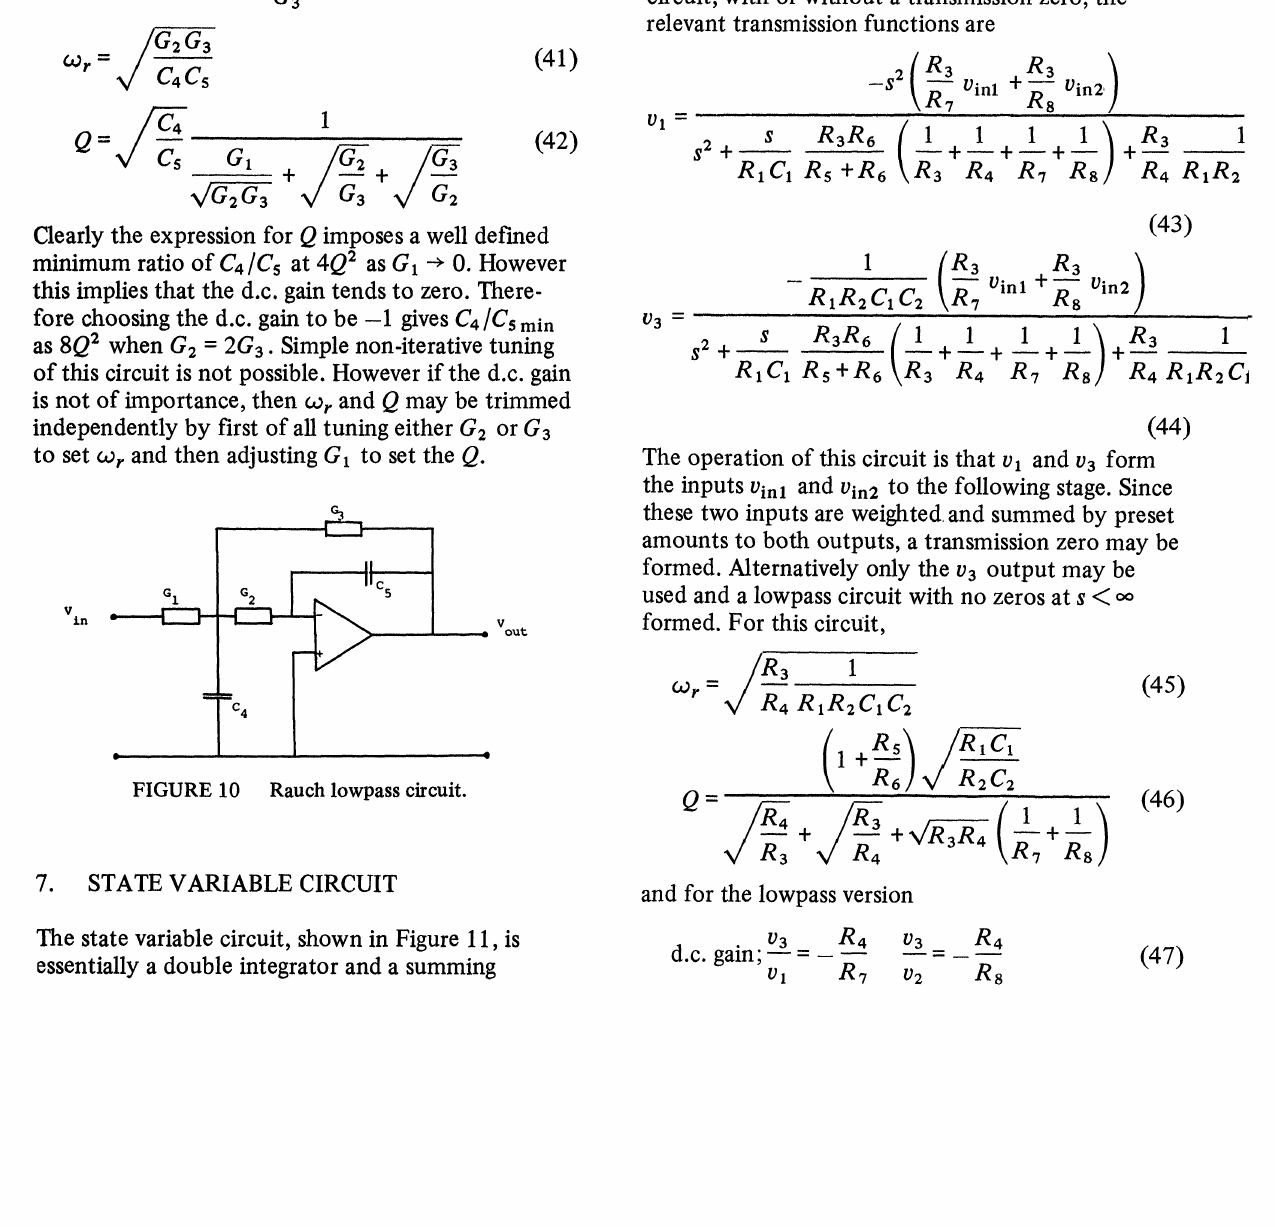
FIGURE 11 State variable